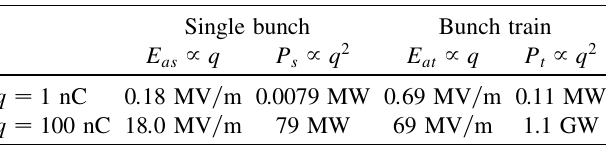
TABLE II. Gradient and power generated in the structure of Table I and driven by a single Gaussian bunch and a bunch train (cid:3) 2 mm ). ( (cid:4) z Single bunch Bunch train